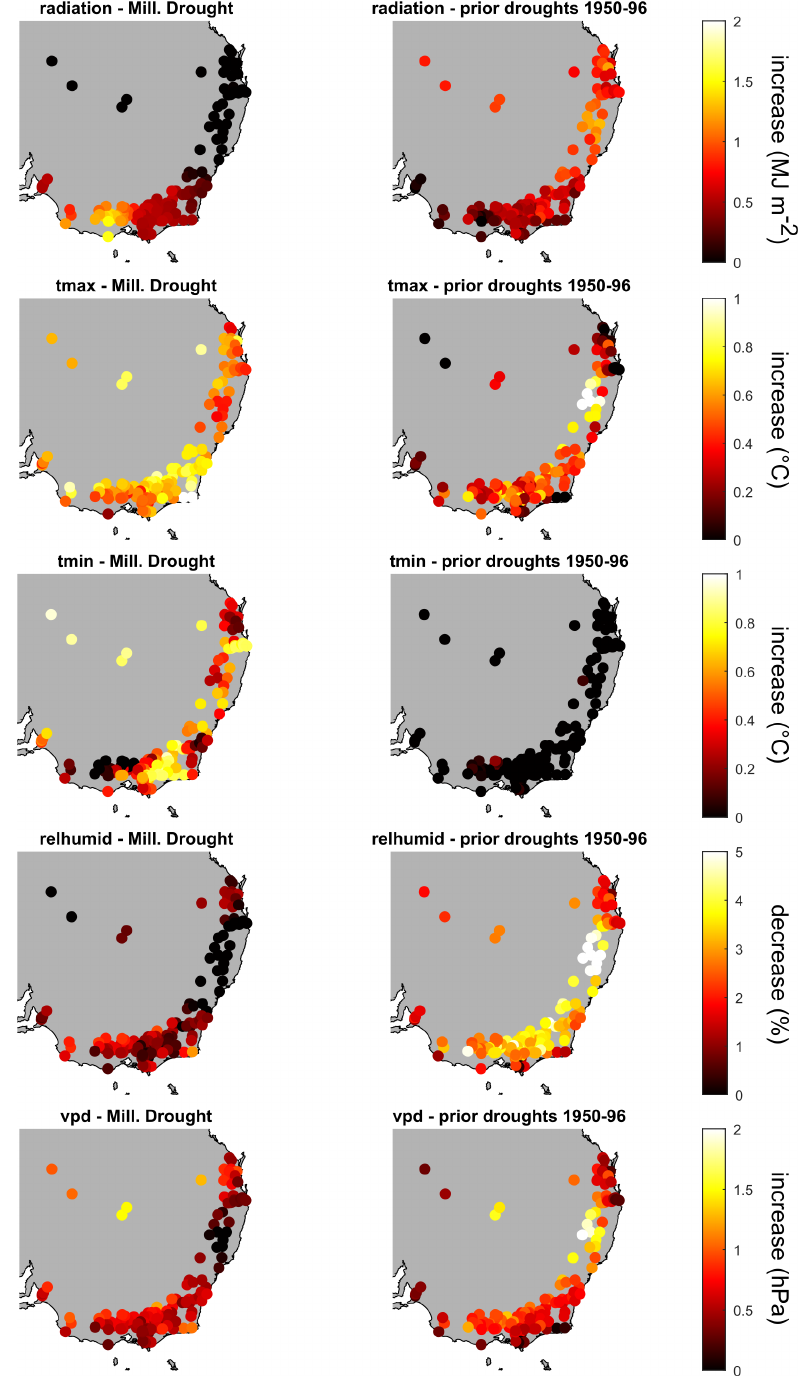
Figure C1. Repeat of Fig. 5d but for five climatic drivers of PET, considering spring months only (September–November). Spring is selected since HPE04/Fig. 5d is focussed on PET in spring. Based on data from Fowler et al. (2021).